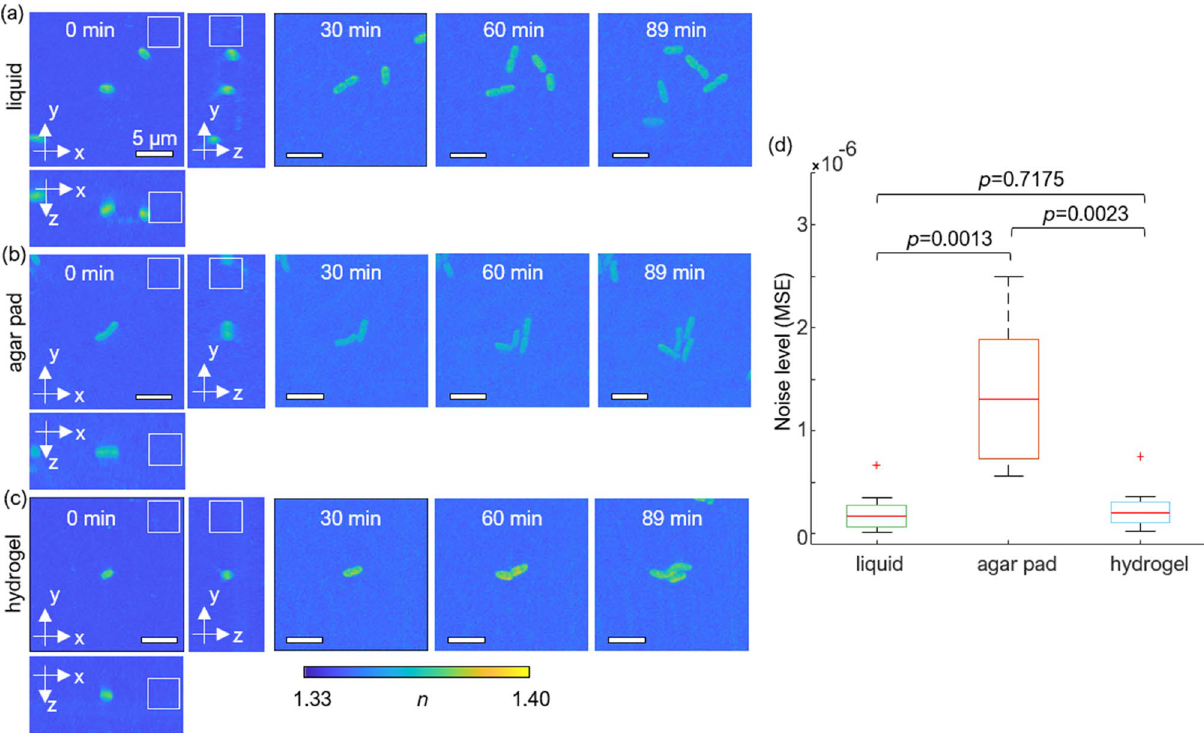
Figure 3. Time-lapse of MIP visualization of 3D RI tomograms of K. pneumoniae in different media: liquid medium ( a ), agar pad ( b ), and hydrogel ( c ). At 0 min, both 3D views of maximum RI projection and volumes marked with white squares which are used to calculate and visualize the RI distribution of background as in ( d ) are indicated. ( d ) Box plot for the noise level of background in different media; liquid medium, agar pad, and hydrogel. The background noise level was assessed from 40 × 40 × 40 pixels without samples in each tomogram. These regions are indicated with white outlines in ( a – c ). The mean squared errors (MSEs) of backgrounds were calculated in nine tomograms for each medium separately. The central mark indicates the median, and the bottom and top edges of the box indicate the 25th and 75th percentiles, respectively. The whiskers extend to the most extreme data points not considered outliers, and the outliers are plotted using ‘ + ’